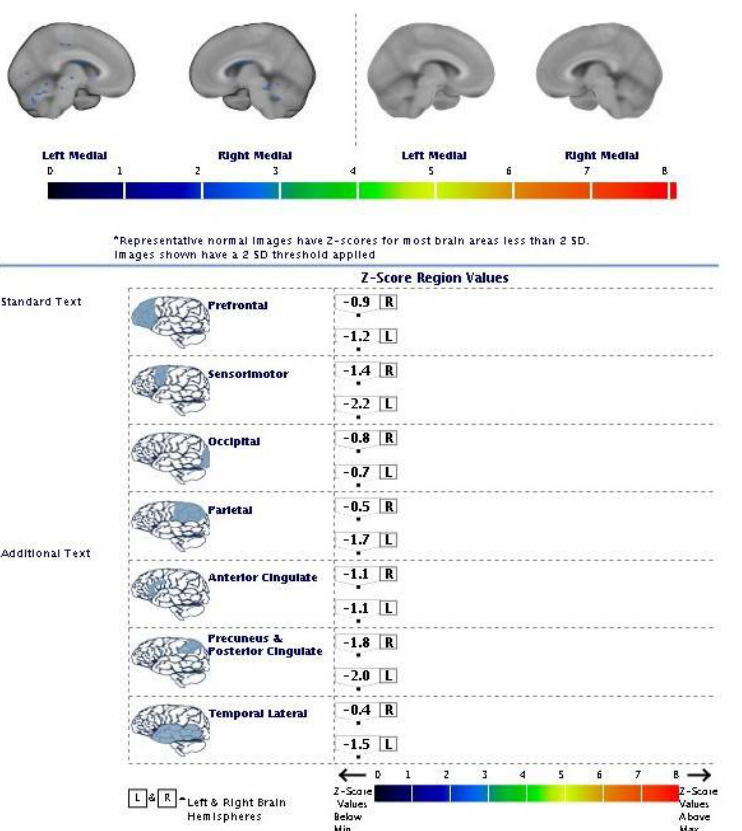
Table 1. Results of neuropsychological assessment in 2021. According to the equivalent score method, raw scores were classed into five ranges corresponding with five categories (0, 1, 2, 3, and 4). We considered pathologic an equivalent score of 0, which indicated a performance corresponding with the worst 5% of the normative sample. TEST